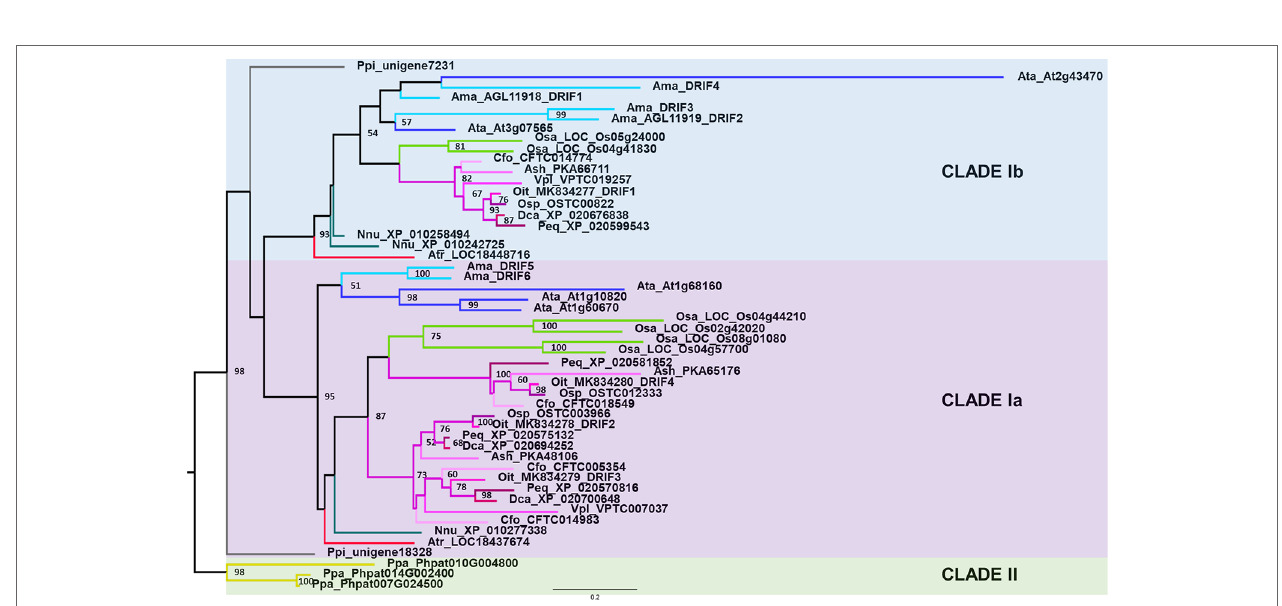
FIgURE 4 | Maximum likelihood tree of the DRIF proteins of orchids and other plant species. The numbers above the nodes represent the bootstrap support percentages (1,000 replicates). Bootstrap values lower than 50% are not shown. The orchid branches are highlighted in different shades of pink . Ama, Antirrhinum majus (light blue); Ata, Arabidopsis thaliana ( blue ); Atr, Amborella tricopoda ( red ); Ash, Apostasia shenzenica ; Cfo, Cypripedium formosanum ; Dca, Dendrobium catenatum ; Nnu, Nelumbo nucifera ( dark green ); Oit, Orchis italica ; Osa, Oryza sativa ( green ); Osp, Ophrys sphegodes ; Peq, Phalaenopsis equestris ; Ppa, Physcomitrella patens ( yellow ); Ppi, Pinus pinaster ( gray ); Vpl, Vanilla planifolia . The code number following the abbreviation of the species name is the accession number of the DRIF sequences deposited in public databases ( Table S1 ).